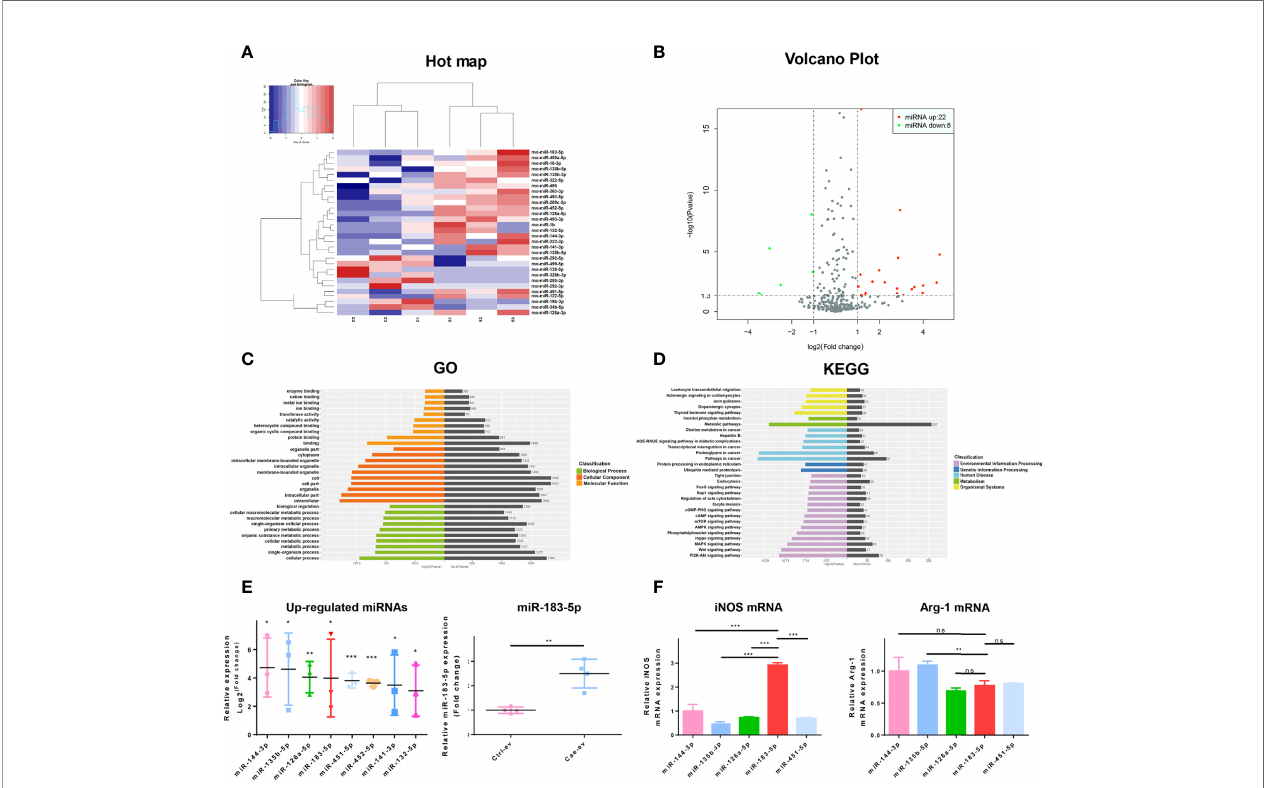
FIGURE 3 | MiR-183-5p is highly expressed in caerulein-induced ACs. (A) Heat map of differentially expressed EV miRNAs. The expression cluster shows the expression level of EV miRNAs on the left of the fi gure. Red indicates high expression, and blue represents low expression. C1, C2 and C3 represent EVs secreted by saline-treated ACs; S1, S2, and S3 represent EVs secreted by caerulein-treated ACs. (B) The volcano plot of miRNAs from AC-derived EVs. Green dots represent downregulated miRNAs, and red dots represent upregulated miRNAs. (C) GO functional enrichment analysis of target genes of upregulated miRNAs. The vertical axis shows the GO term, and the horizontal axis shows the P - value and gene number. (D) KEGG pathway analysis revealed the top 30 enriched pathways involving the target genes of upregulated miRNAs. (E) The expression of the top eight upregulated miRNAs in EVs measured by sequencing. The expression of miR-183-5p in Ctrl-ev and Cae-ev was detected using qRT-PCR (F) After the overexpression of miRNAs in BMDMs, iNOS and Arg-1 mRNA expression in BMDMs were detected by qRT-PCR. Data are presented as the mean ± SD. All experiments were repeated three times. * p <0.05, ** p <0.01, *** p <0.001. KEGG Kyoto Encyclopedia of Genes and Genomes, GO Gene Ontology. Ctrl-ev: EVs derived from PBS-treated acinar cells, Cae-ev: EVs derived from caerulein-treated acinar